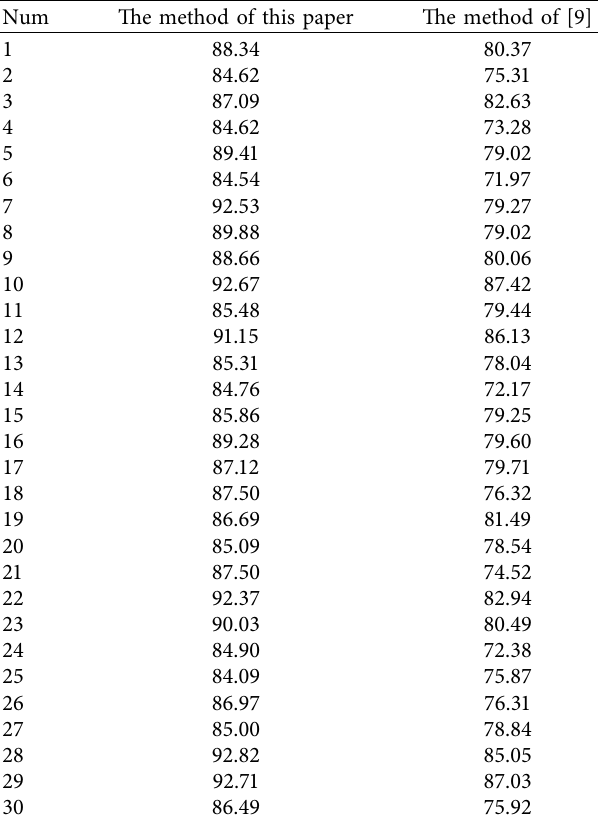
Figure 8: Music genre classification based on multihead attention mechanism. Table 1: Music genre classification effect of the music genre classification algorithm based on the multihead attention mechanism.